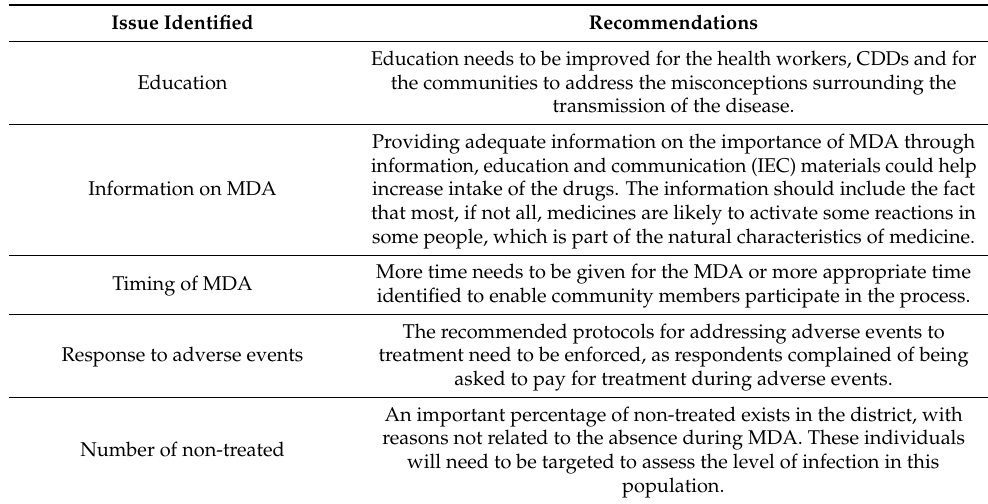
Table 7. Recommendations to issues